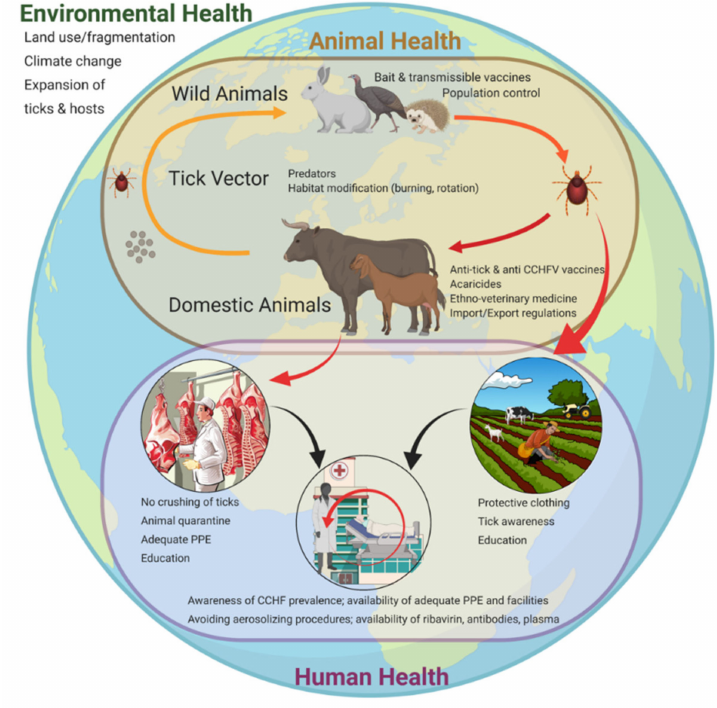
Figure 1. Crimean-Congo hemorrhagic fever virus (CCHFV) routes of transmission and associated intervention measures within the three realms of One Health. Environmental health (outer circle), including climate change and land use, influences several aspects of CCHFV transmission, including tick and animal host distribution and density; tick–animal host interactions a ff ect the overall animal health status and livestock production levels (brown circle). The virus transmission pressure between ticks and animals increases progressively with the life cycle of the tick (reflected by the color gradient of the arrows from light orange to dark orange to red). Human health (purple circle) overlaps with the animal health realm through virus transmission routes, most commonly through tick bites or crushing of ticks, and secondarily through contact with viremic animal blood during the slaughtering process. Human-to-human transmission can also occur in a household or nosocomial setting when no proper personal protective equipment is